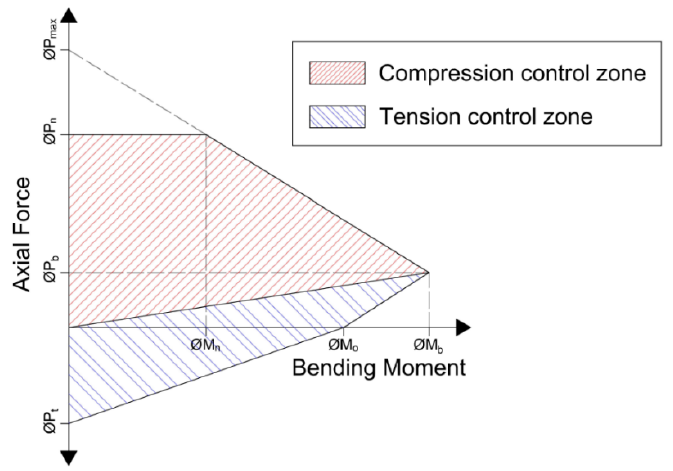
Figure 7. Interaction diagram linear approximation. Table 8. Auxiliary members’ constraints summary.